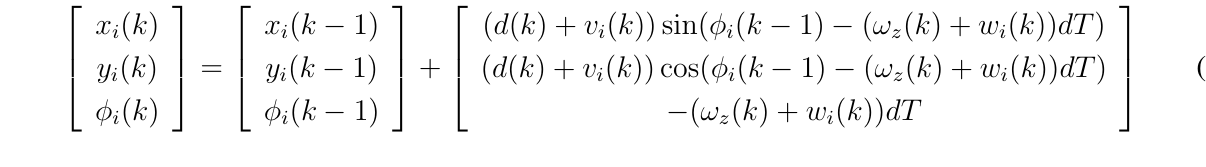
Figure 15. An explanation of the unperturbed state transition: d ( k ) is the length of a ( k ) is the angular step estimated by the pedometer. φ ( k ) is the azimuth orientation. ω z velocity around the gravity axis. ω is estimated by the gyroscope and the gravity estimation z algorithm. ( x ( k − 1) , y ( k − 1)) , ( x ( k ) , y ( k )) are the coordinates in the previous and